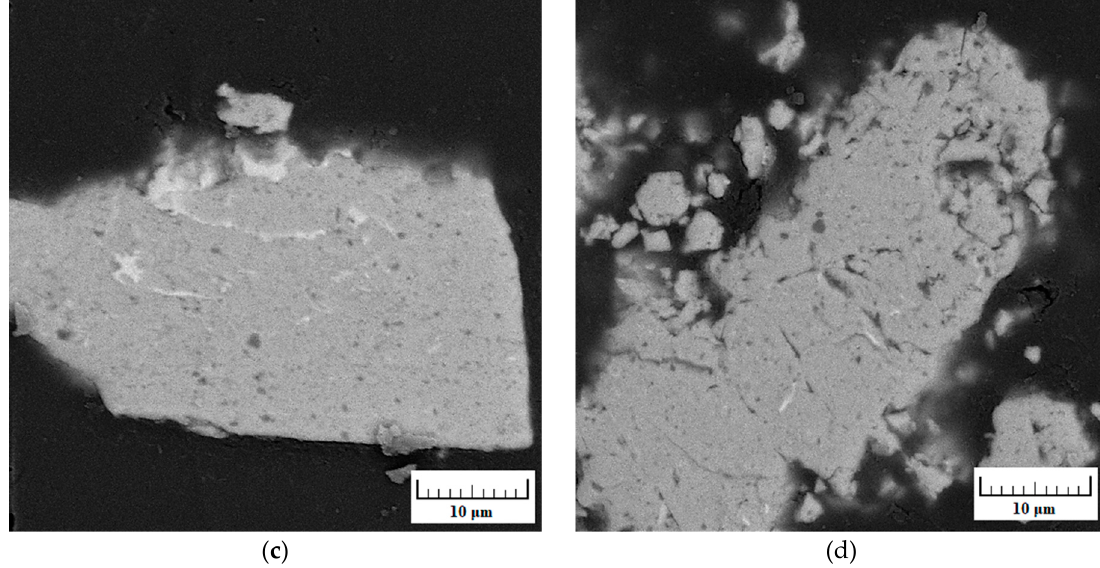
Figure 4. The SEM micrographs of the FeAl35Si5 alloy after: ( a ) 0.5 h, ( b ) 1 h, ( c ) 2 h, ( d ) 4 h of MA.